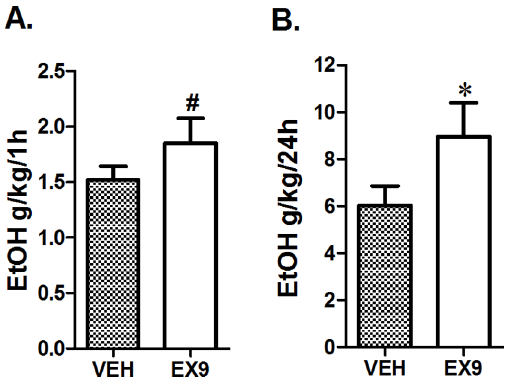
Figure 2. Peripheral administration of GLP-1 reduces alcohol reward. Mice treated with vehicle on the testing day spent significantly more time in the compartment previously (during the conditioning sessions) paired with alcohol as compared to the compartment paired with saline. In contrast, mice treated with 0.02 mg of GLP-1 spent an equal amount of time in both the saline- and alcohol-paired compartments (A). Alcohol induced a significant preference for the compartment it was paired with over the compartment paired with saline during the conditioning sessions in NMRI mice injected with vehicle (n=48) but not those treated with GLP-1 (n=31) (B). %CPP was determined with the following formula ((test-pretest)/(total time- pretest)) 6 100 to indicate the % preference above a neutral response (i.e. equal preference for each compartment). All values represent mean 6 SEM. *p , 0.05, **p , 0.01.